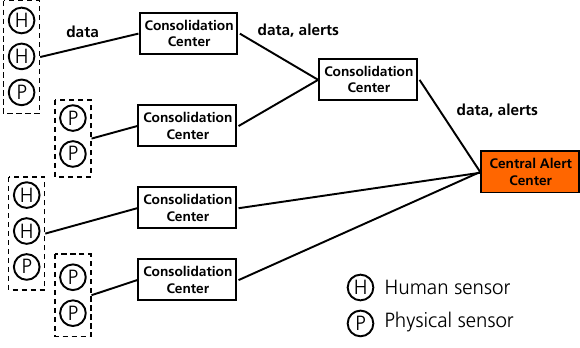
Fig. 1. In its very essence a Tsunami Warning system converts phys- ical effects related to a Tsunami, such as vibration or pressure to adequate and timely warnings and advice to individuals.